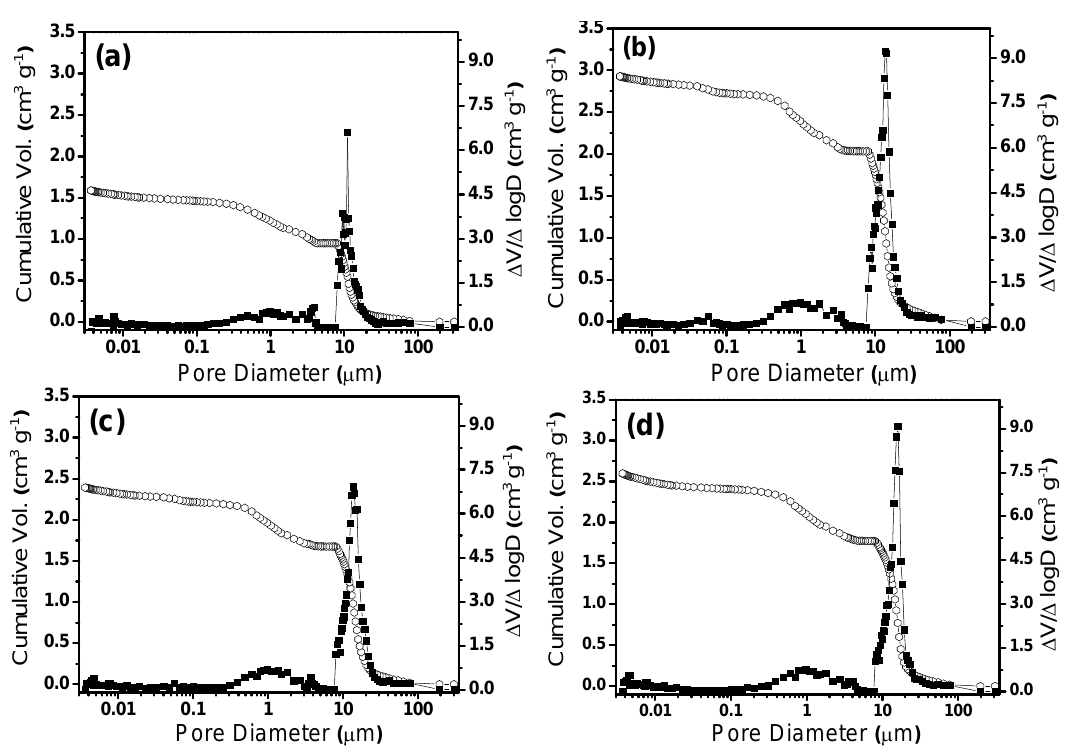
Figure 7. Cumulative and differential pore size distributions for ceramic foams fired